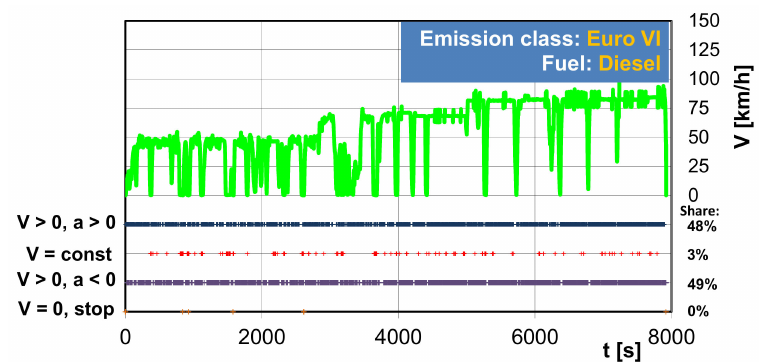
Figure 14. Distribution of speed over time in N2 category vehicle.